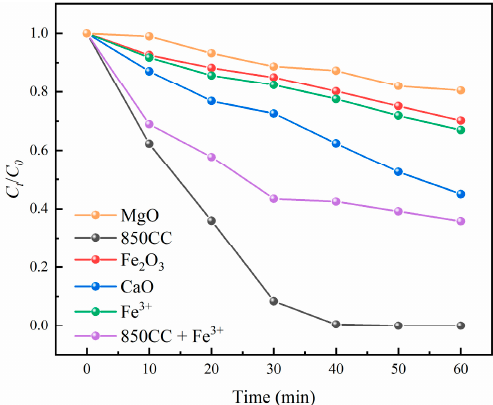
Figure 8. Degradation of RhB in CaO/PMS, Fe 2 O 3 /PMS, homogeneous Fe 3+ /PMS and 850CC/PMS with additional Fe 3+ . Control conditions: (PMS) = 1 mM, (MgO) = 300 mg/L, (Fe 2 O 3 ) = 35 mg/L, (Fe 3+ ) = 1.1 mg/L, (CaO) = 30 mg/L, temperature = 30 °C.